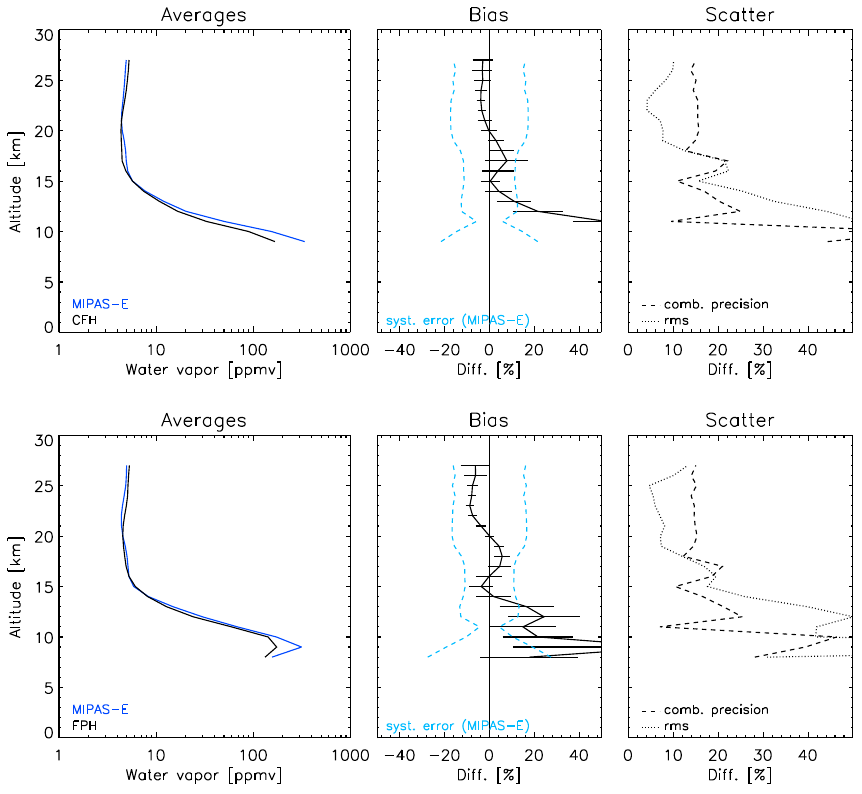
Fig. 11. Same as Fig. 9 but for CFH v3.20 (top row) and NOAA FPH (bottom row) frost point hygrometer profiles of water vapor. For a more detailed description see Fig. 9.